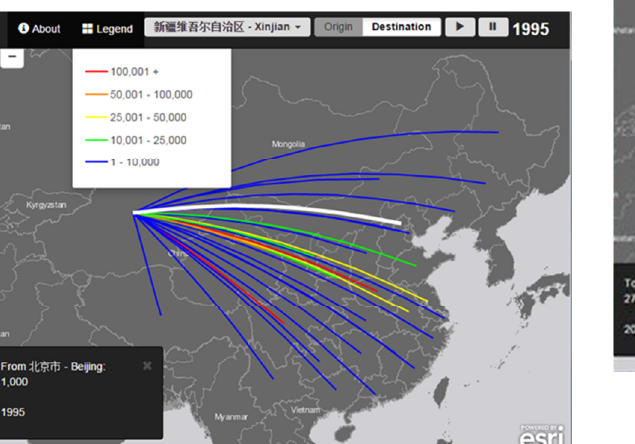
Figure 6a Migration into Xinjiang in 1995